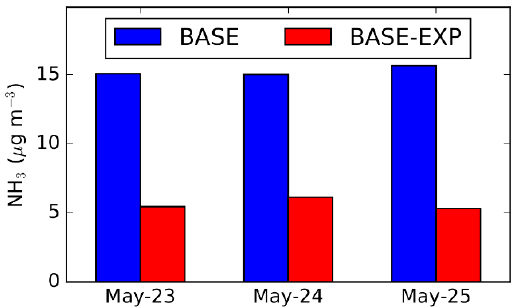
Figure 8. Bar plot showing the daily NH 3 concentrations in Beijing derived from the BASE run and contributed by the southern plain regions (BASE-EXP).